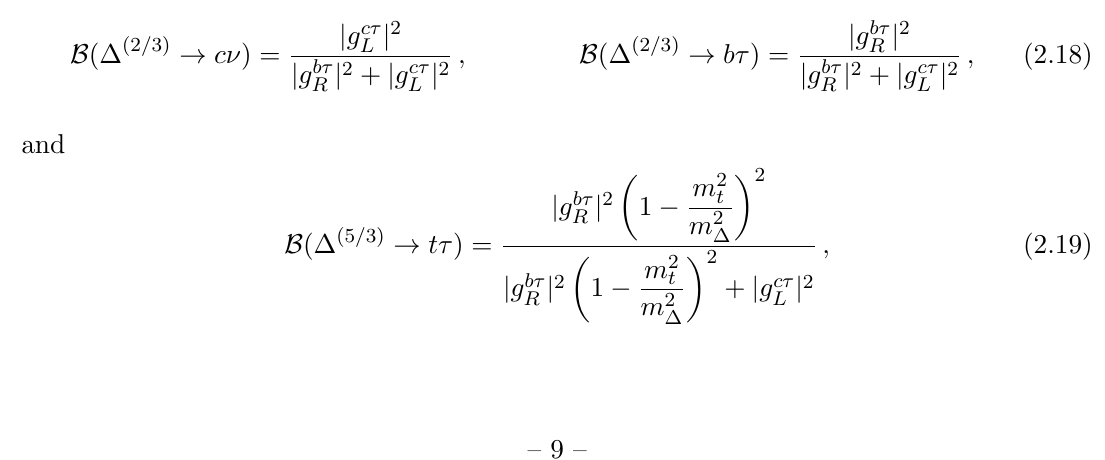
((cid:1) (2 = 3) b(cid:28) ) [70, 71], ((cid:1) (5 = 3) t(cid:28) ) [72, 73] B ! B ! ((cid:1) (2 = 3) b(cid:28) ) (upper left B !